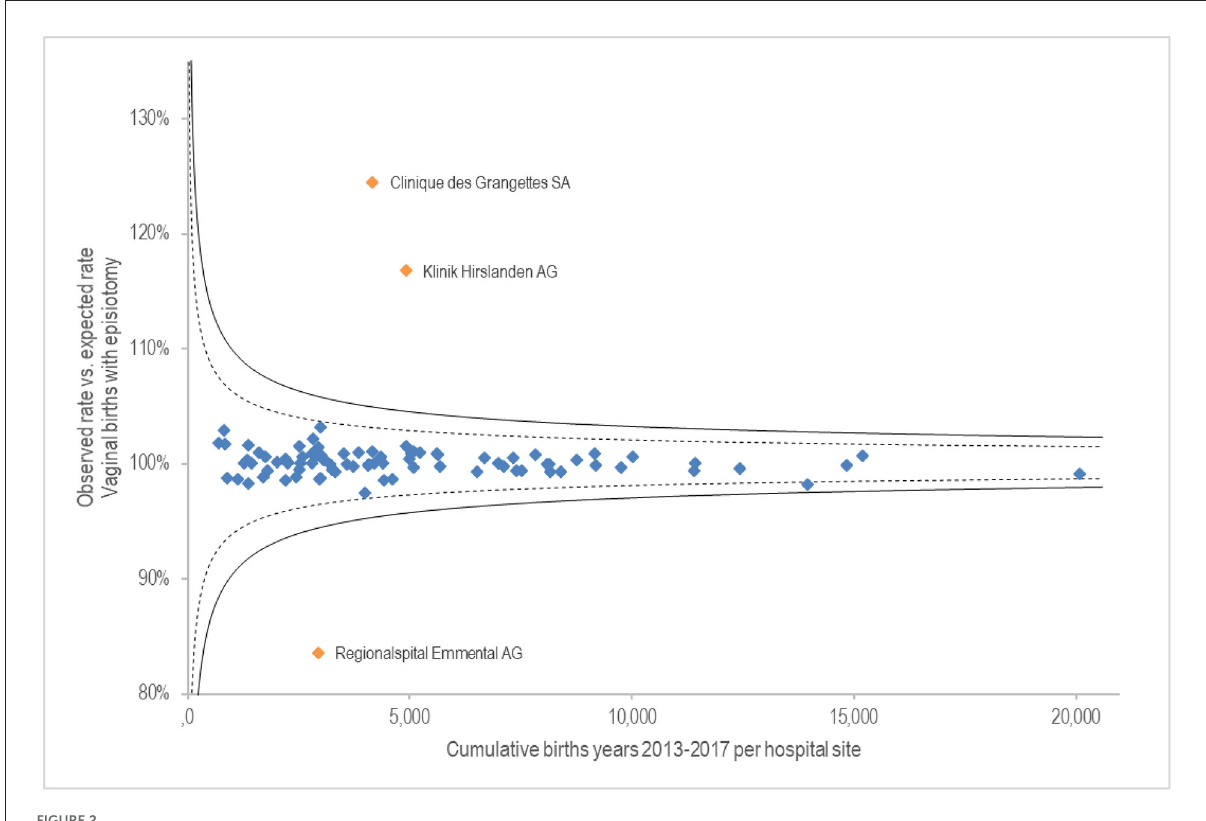
FIGURE2 G.1.3.P Proportion of vaginal births with